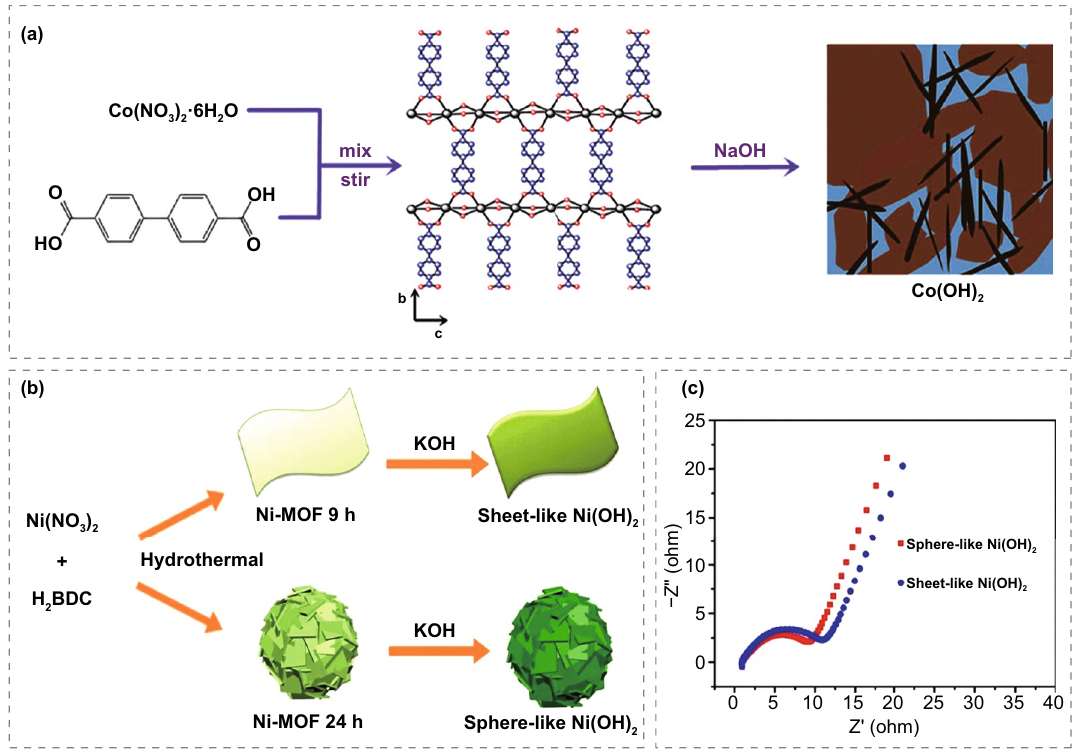
Fig. 13 a Schematic illustration of the formation process for MOF-derived Co(OH) 2 . Reprinted with permission from Ref. [158]. Copyright 2015 Royal Society of Chemistry. b Illustration of the synthetic procedure of sheet-like Ni(OH) 2 and sphere-like Ni(OH) 2 . c The eis of sheet-like and sphere-like Ni(OH) 2 . Reprinted with permission from Ref. [159]. Copyright 2019 Springer Science Business